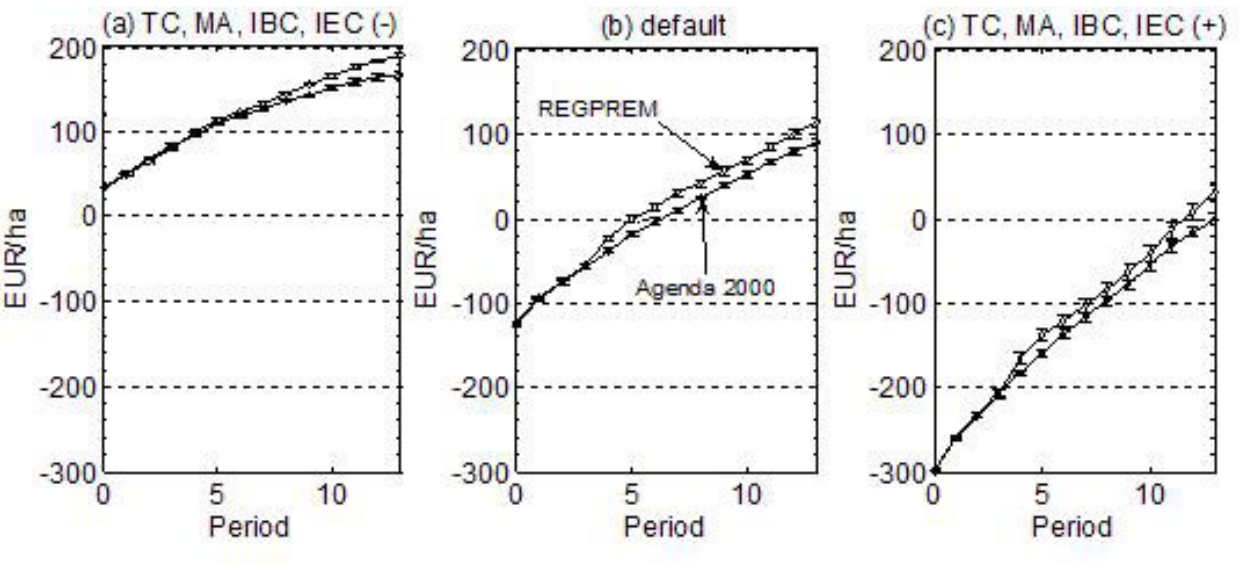
Fig. 6. Evolution of average economic land rent and sunk costs/ha over 14 simulation periods and two policies, i.e., Agenda 2000 and the decoupled policy (REGPREM) for low factor levels (-), default, and high factor levels (+). Averages of five replications and standard